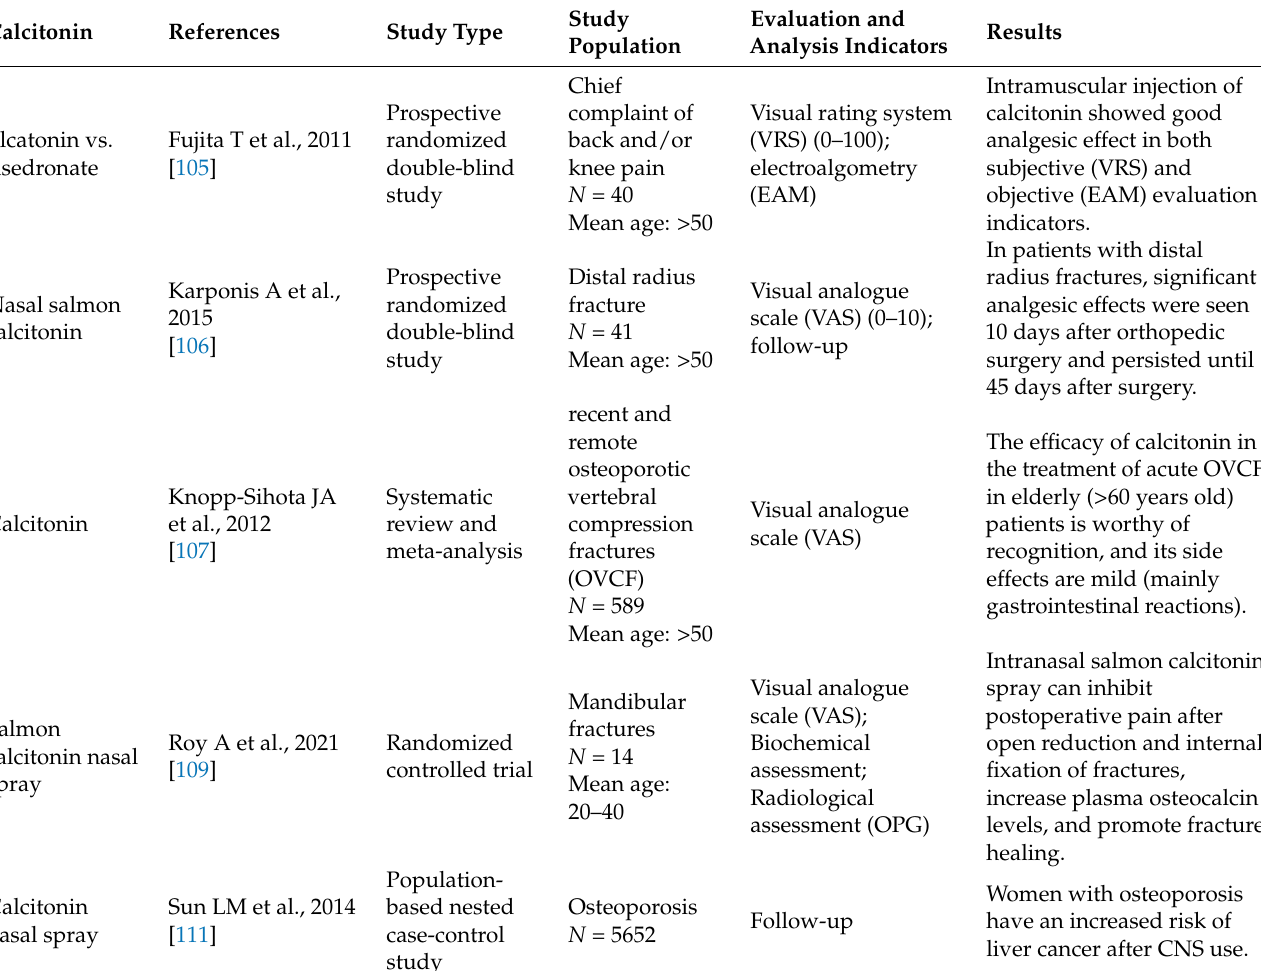
Table 3. Calcitonin and its related clinical